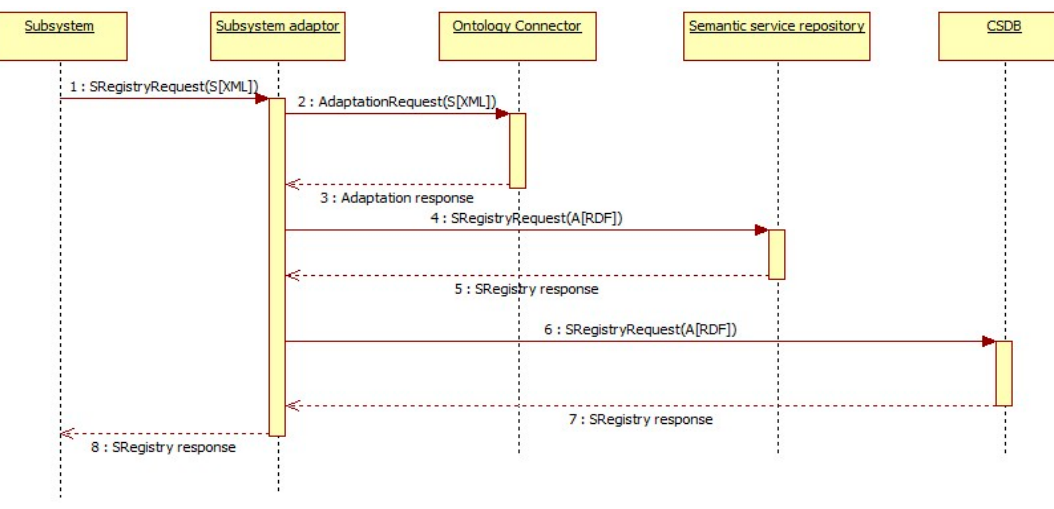
Figure 11. Subsystem registratiom sequence diagram.